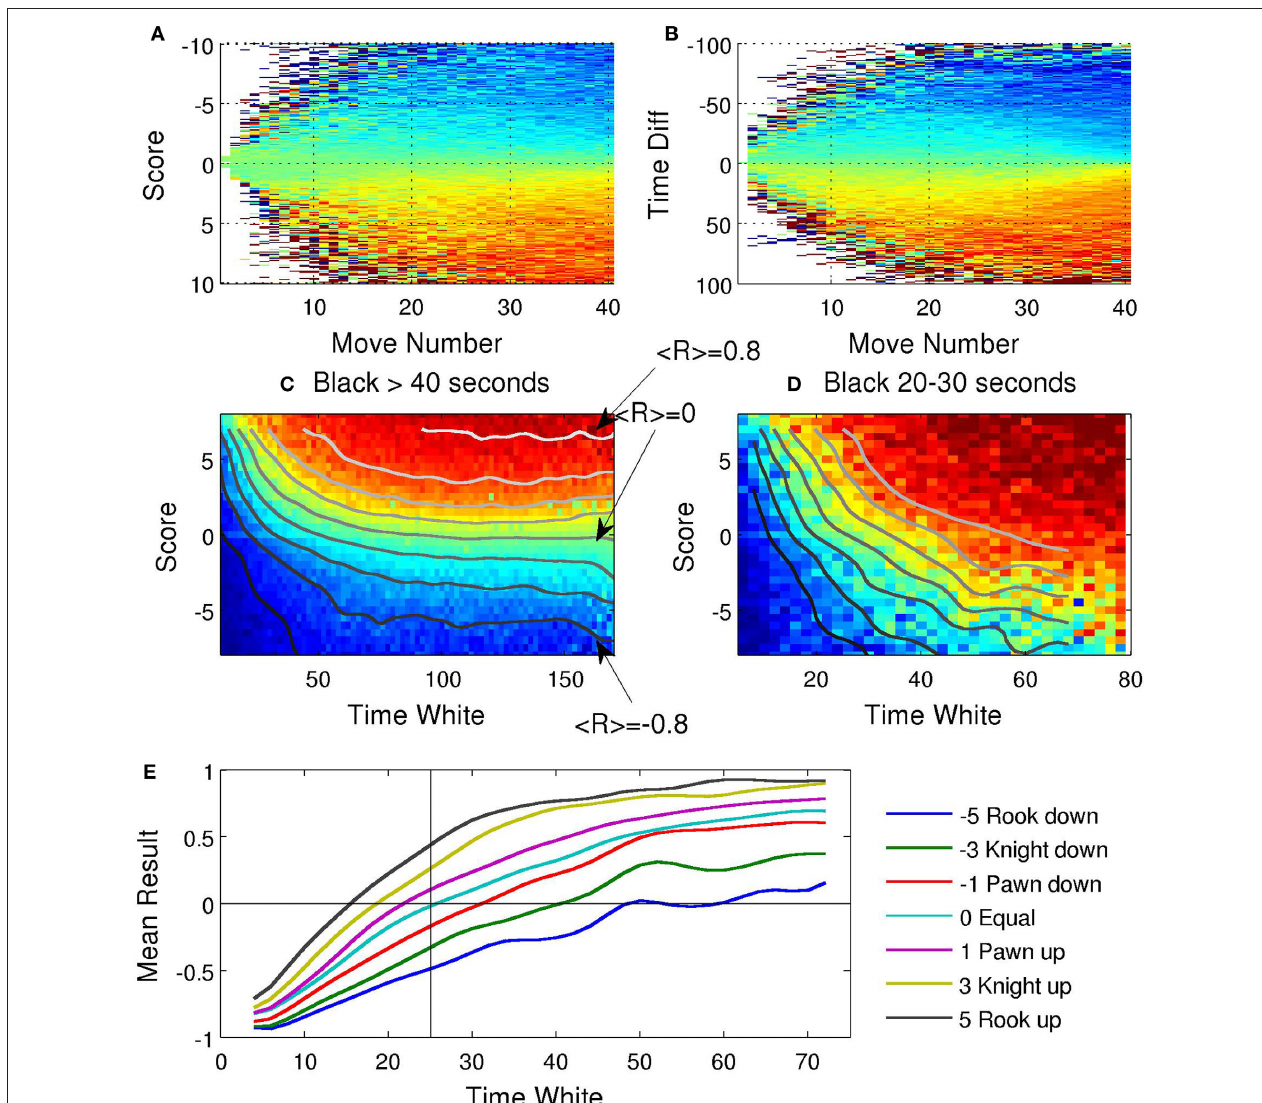
lines along which the average game result does not change, thus indicating how time and score have to covary to maintain the winning probabilities constant. (D) Same as in (C) when black is in time trouble. (e) Mean result as a function of time left for white (when black has between 20 and 30 s). Each line corresponds to a different score. Note that when the score is + 5 (i.e., a rook up) winning probabilities are equal if white has around 17 s. For this time configuration, 8 s is worth a